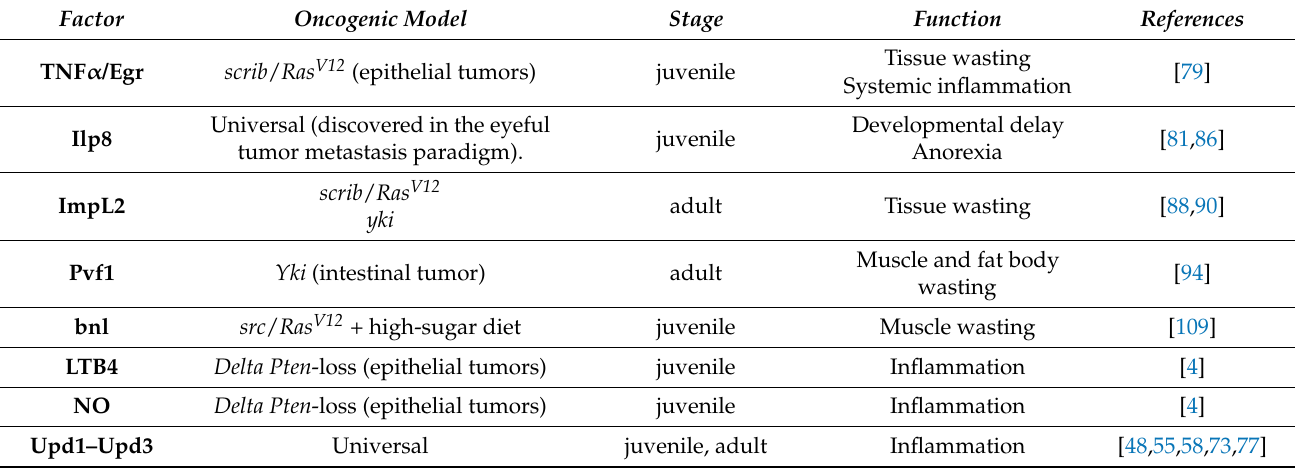
Table 1. Tumor- and tumor microenvironment-secreted factors: local and systemic effects. Factor Oncogenic Model Stage